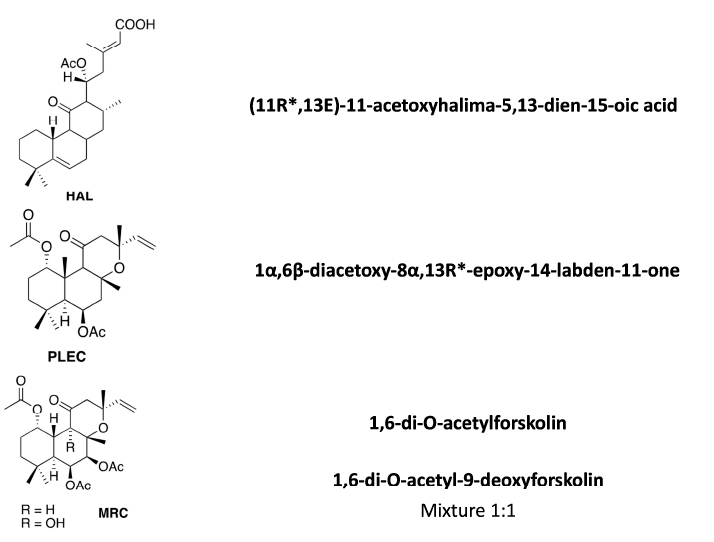
Figure 1. Diterpenes isolated from the described Plectranthus ornatus Codd. plant.